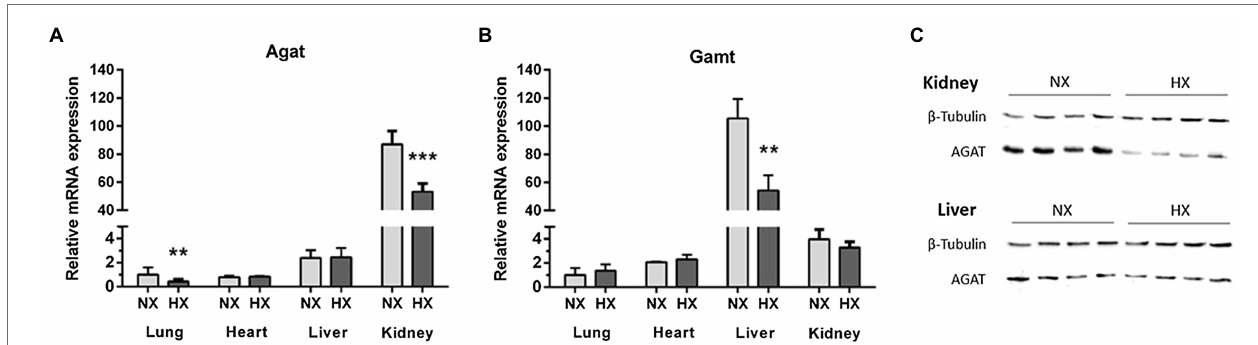
FIGURE 3 | Agat and Gamt mRNA expression in lungs, liver, heart, and kidneys, and L-arginine:glycine amidinotransferase (AGAT) protein expression in liver and kidneys. mRNA expression of Agat (A) and Gamt (B) in normoxia (NX) and hypoxia (HX) as determined by quantitative real-time PCR normalized to Tbp as housekeeping gene. (C) Western Blot of AGAT in liver and kidneys as compared to β -tubulin as loading control. ** p < 0.01 and *** p < 0.001 vs. NX (ANOVA with Bonferroni post-hoc